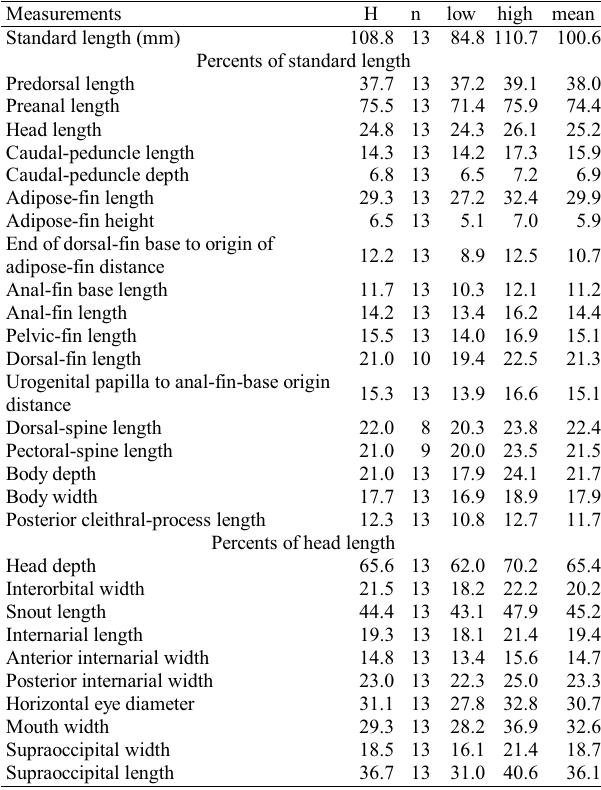
Table 2. Morphometric data of Pimelodus halisodous . Range includes the holotype (H).